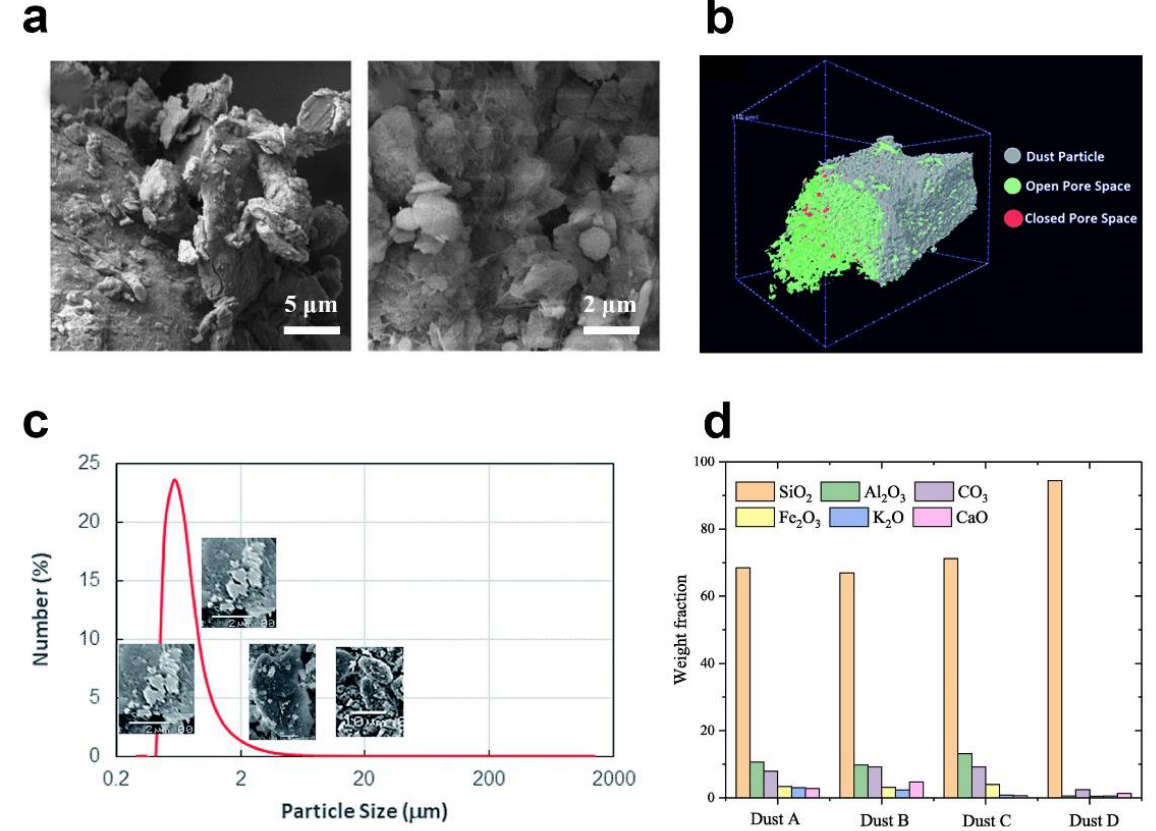
Figure 2. ( a ) SEM images of dust particles, reproduced with permission from Ref. [52]; ( b ) CT image of dust particles, reproduced with permission from Ref. [19]; ( c ) particle size distribution of dust particles, reproduced with permission from Ref. [18]; and ( d ) content and composition of dust particles, reproduced with permission from Ref. [5]. Table 1. Dust particle composition in different areas.